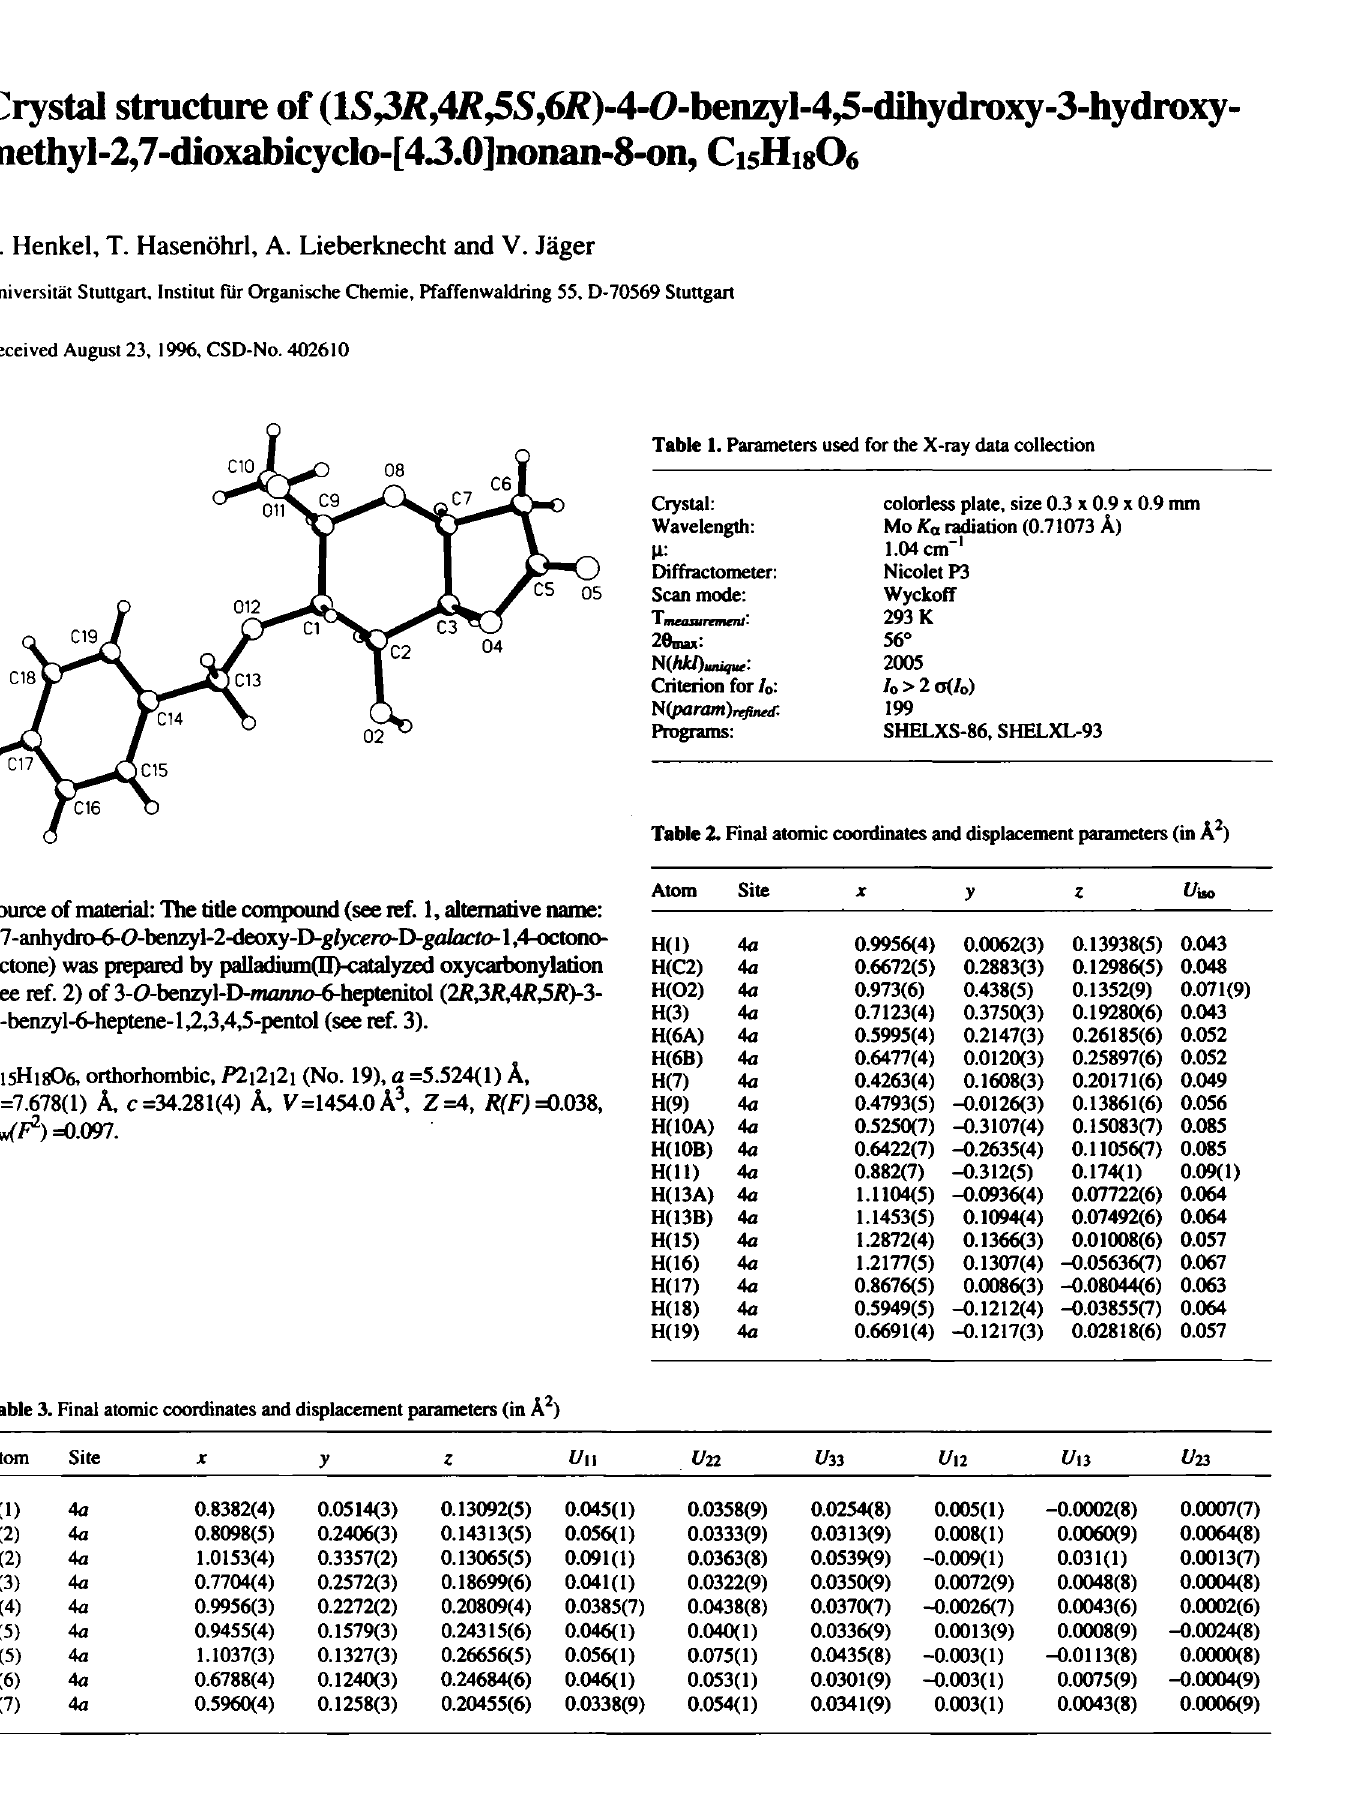
Table 3. Final atomic coordinates and displacement parameters (in Â 2